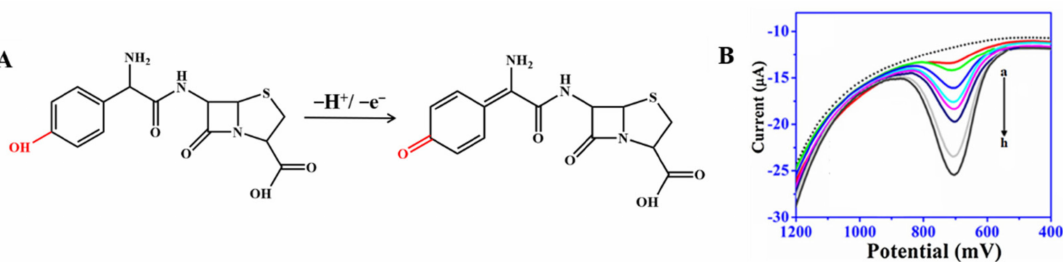
Figure 4. ( A ) Mechanism for the electrochemical oxidation of amoxicillin; ( B ) Square-wave voltammo- grams recorded for amoxicillin of different concentrations using AuNP-PdNP-ErGO/GCE. Reprinted with permission from. Adapted with permission from Ref. [42]. Copyright 2017